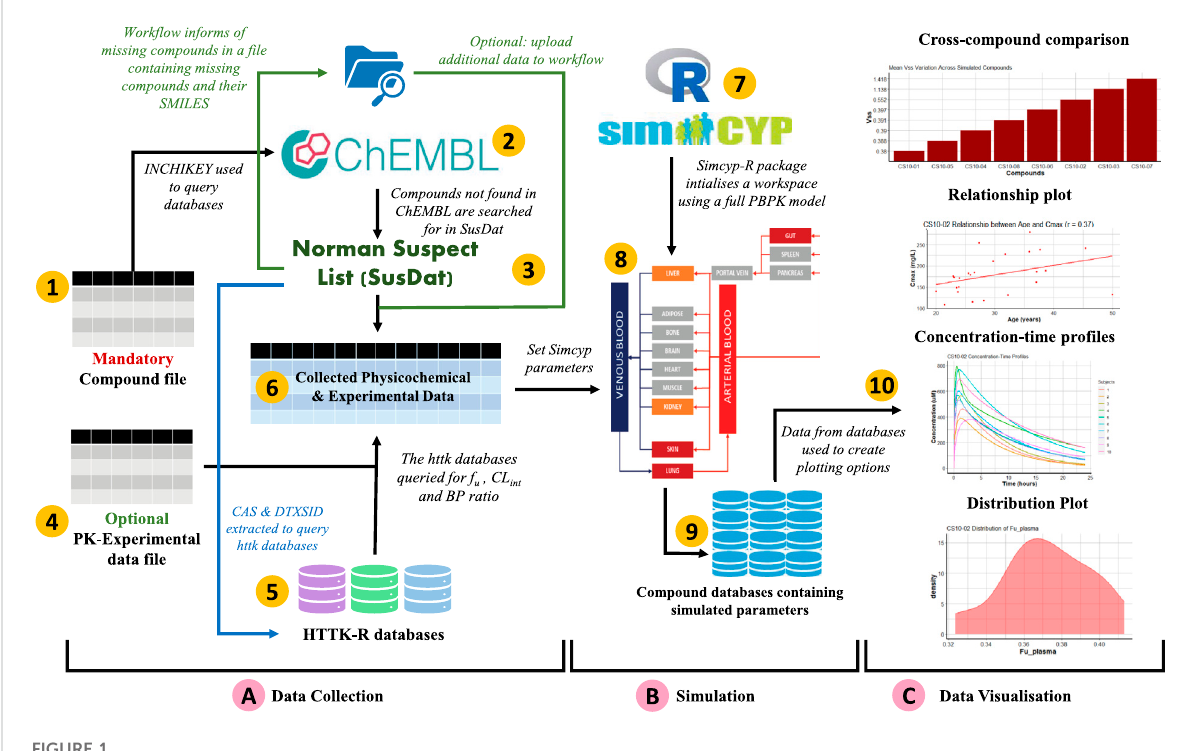
FIGURE 1 Schematic representation of SimRFlow which is comprised of three main modules as shown by the square brackets (A) Data Collection, (B) Simulation, and (C) Data